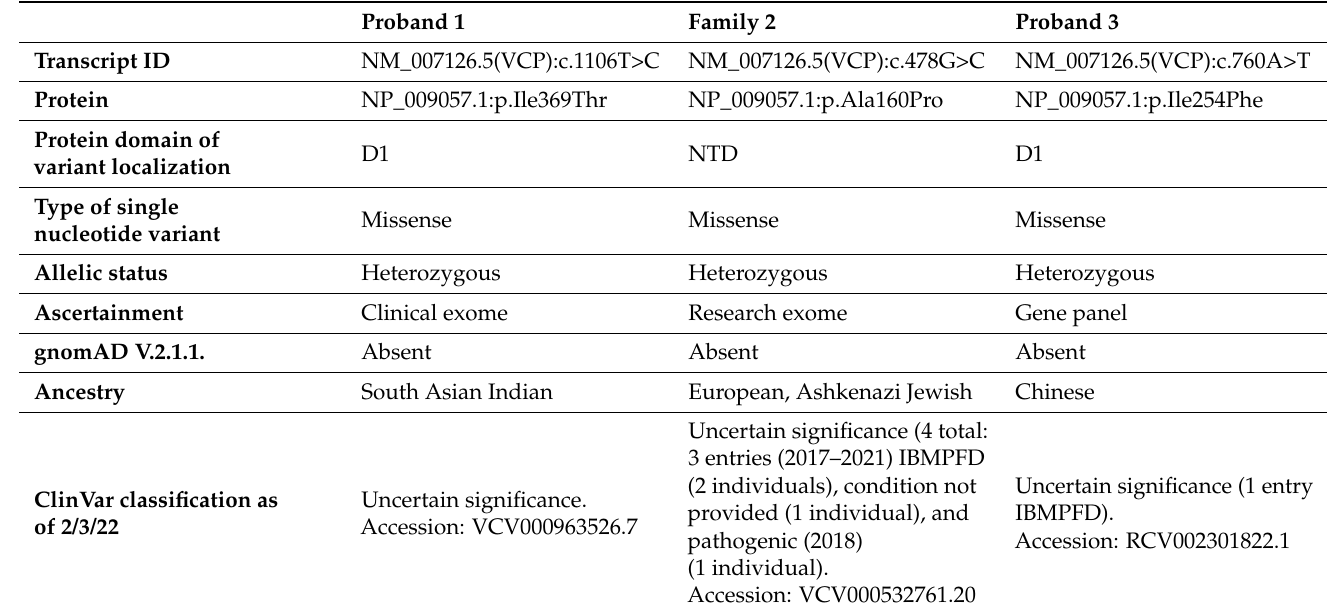
Table 2. Prediction of the likely impact of novel